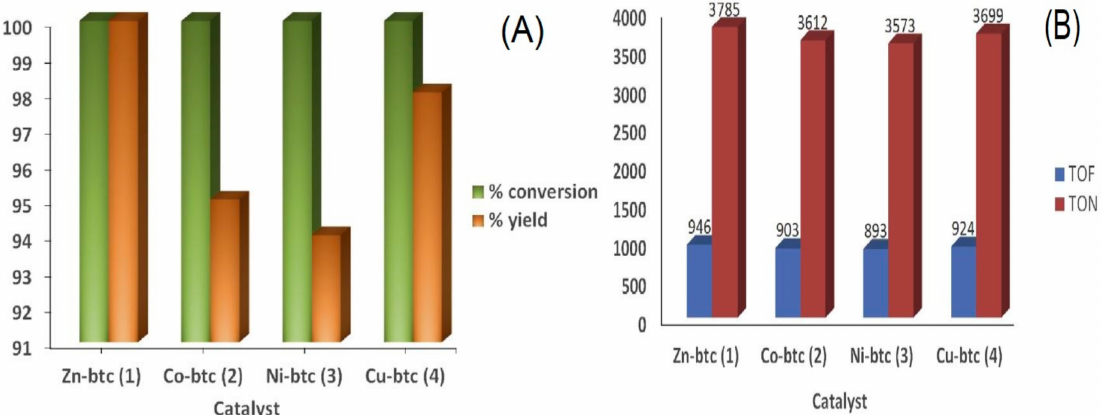
Figure 24. ( A ) The conversion (%) and yield (%) ( B ) TON and TOF: for cycloaddition conversion of CO 2 to PC using M-btc MOFs (M = Zn, Co, Ni, and Cu). Reaction condition: temperature, 120 ◦ C; CO 2 pressure, 0.7 MPa; time, 4 h. Reprinted with permission from Ref. [58]. Copyright 2019